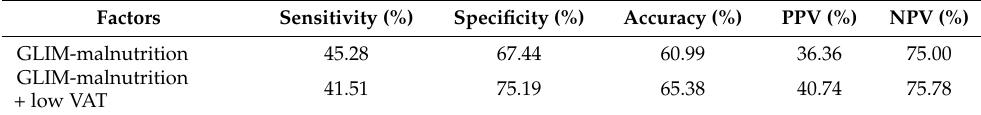
Table 4. Sensitivity and specificity of different malnutrition diagnoses for the prediction of NT-related adverse